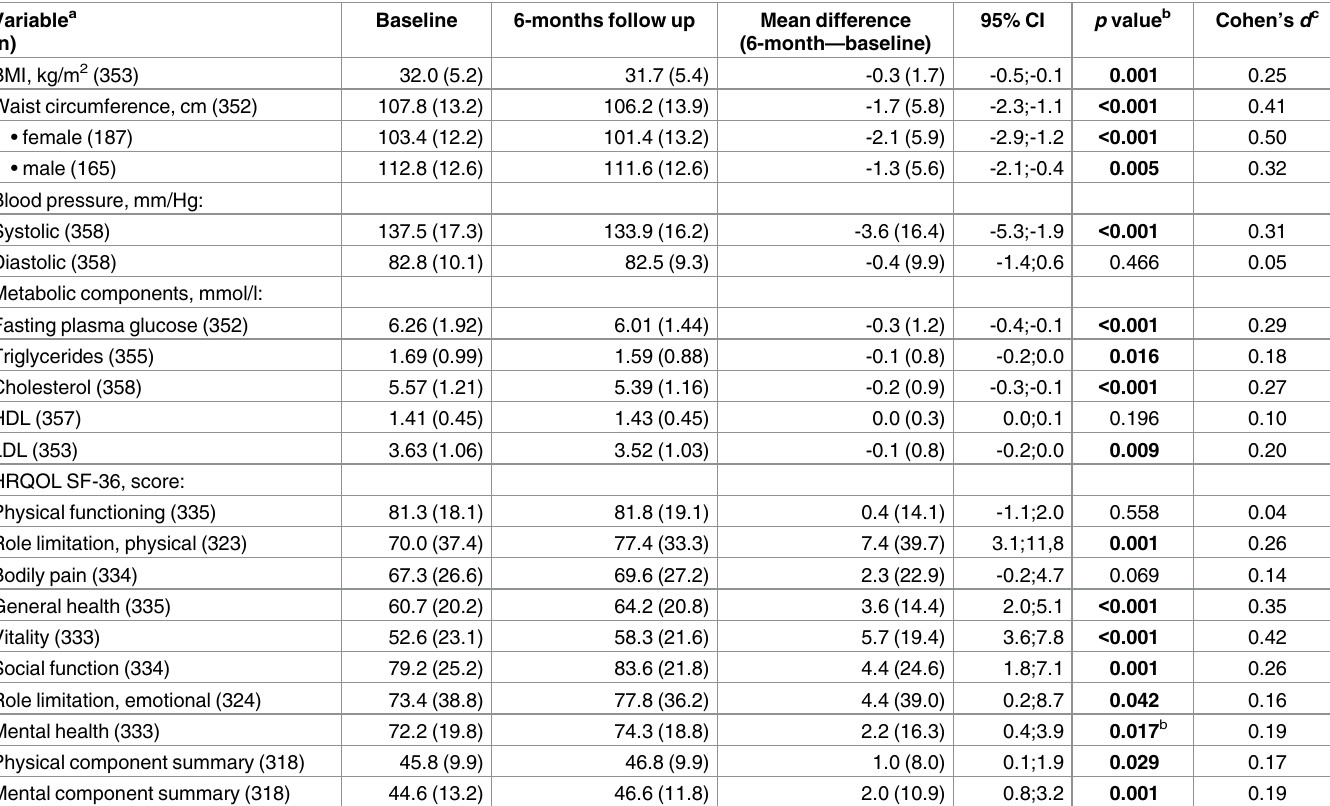
Table 5. Descriptivestatistics and differences for anthropometric-, metabolic characteristics and health related quality of life at baseline and 6-month